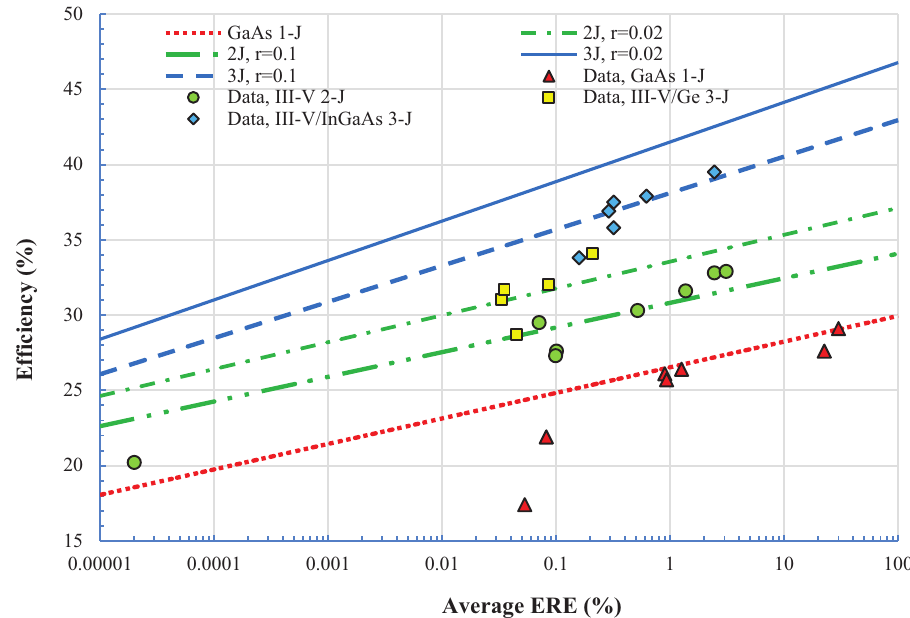
Fig. 3. Calculated ef fi ciencies of GaAs single-junction, III – V 2-junction, III – V/Ge 3-junction and III – V/InGaAs 3-junction solar cells as a function of average ERE in comparison with the state-of- the-art ef fi ciencies of those solar cells including chronological ef fi ciency improvements.